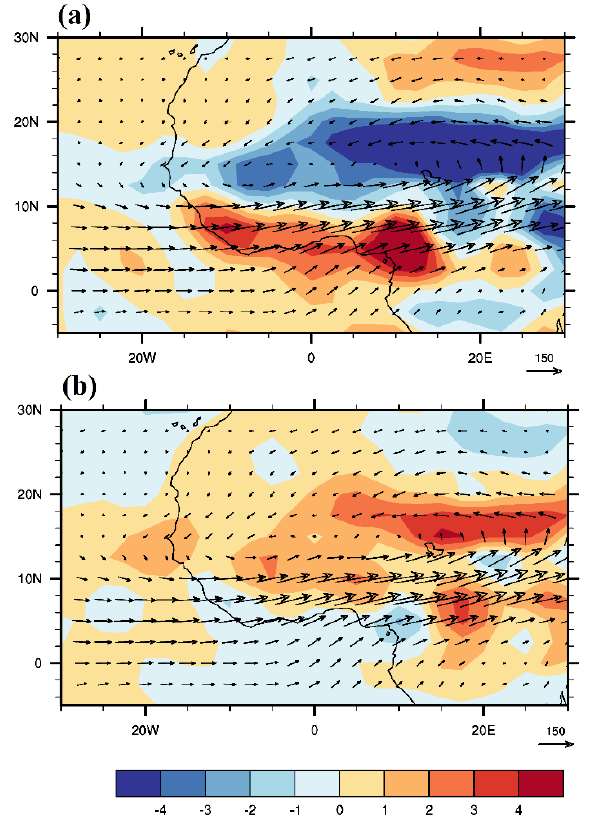
Figure 6. Vertically integrated moisture flux (vectors; kg m − 1 s − 1 ) and moisture divergence (shading; 10 − 4 kg m − 2 s − 1 ) anomalies for ( a ) wet and ( b ) dry years.